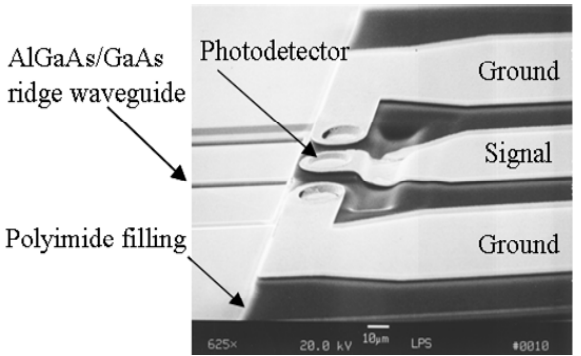
Figure 10. Reflectively coupled waveguide photodetector with metal coplanar waveguide [22].